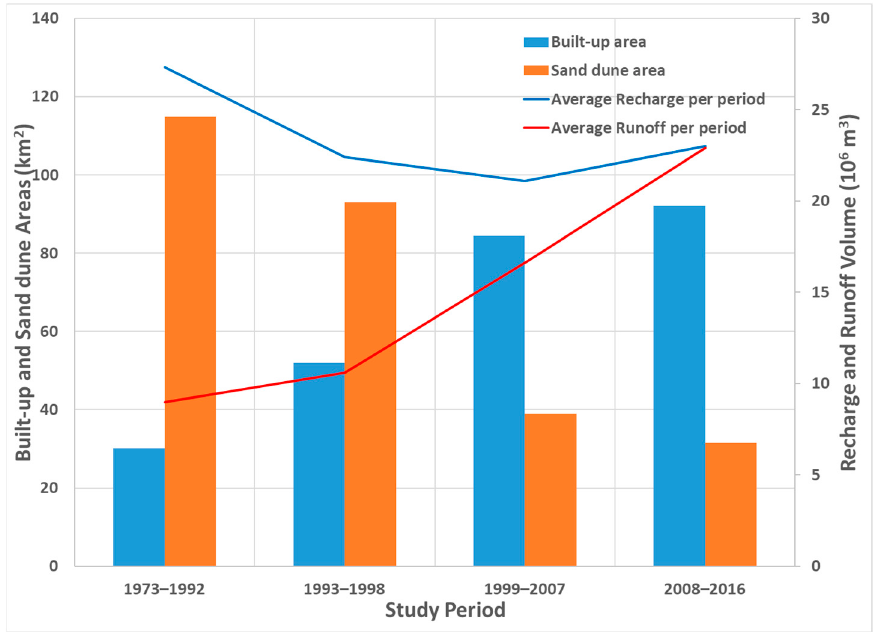
Figure 6. Relation between built-up and sand dune areas versus runoff and recharge over the entire period